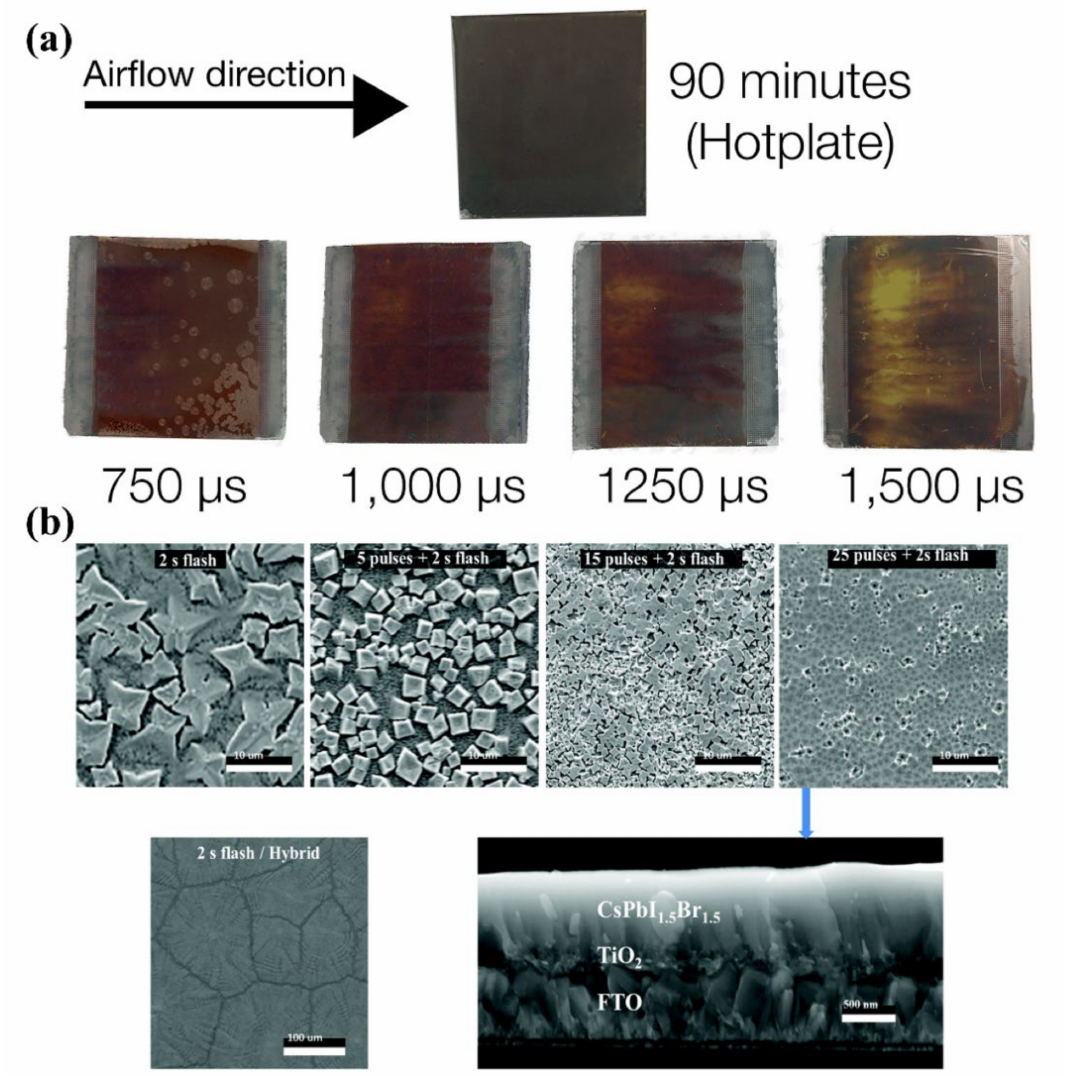
Figure 8. ( a ) Composed photograph of photonic annealed MAPbI 3 − x Cl x perovskite sample with increasing flash durations at 500 V lamp voltage as well as a film annealed in a hotplate. (Reprinted with permission from Ref. [81]. Copyright 2016 Royal Society of Chemistry). ( b ) SEM images of thin films annealed at four different flash pulses and the cross-sectional images of annealed CsPbI 1.5 Br 1.5